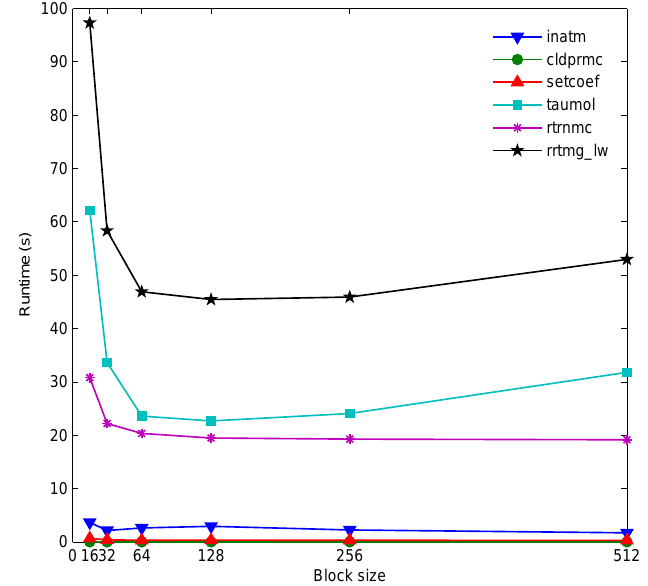
Figure 5. Runtime of the G-RRTMG_LW on one K20 GPU.